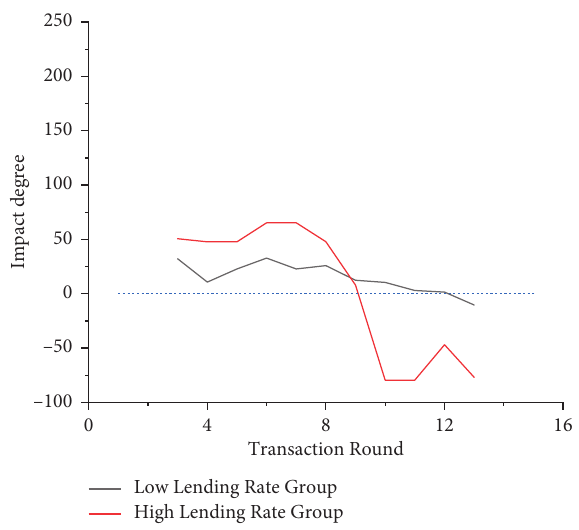
Figure 5: The effect of the two lending rate groups on regulating housing prices. Table 10: Nonparametric test of indicators between groups of lending interest